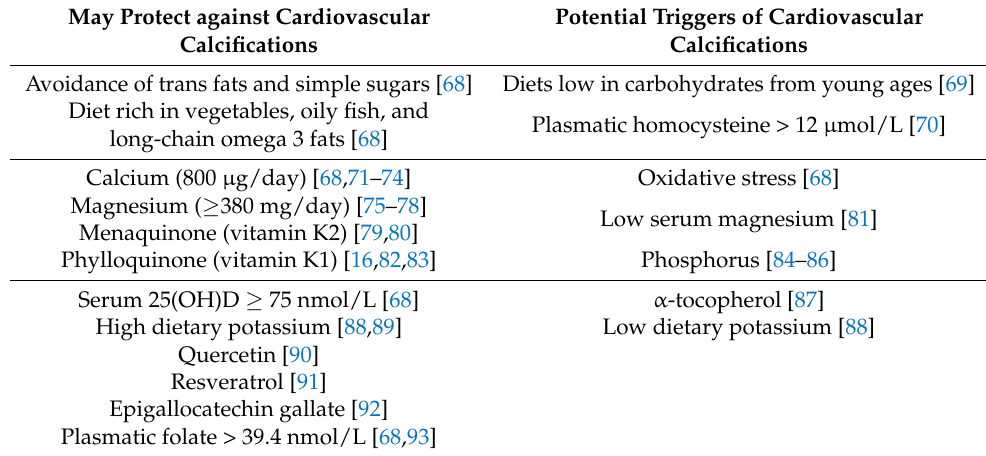
Table 2. Dietary recommendations and their contribution to vascular calcification.